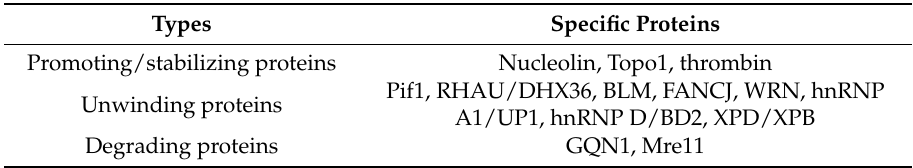
Table 2. Proteins interacting with